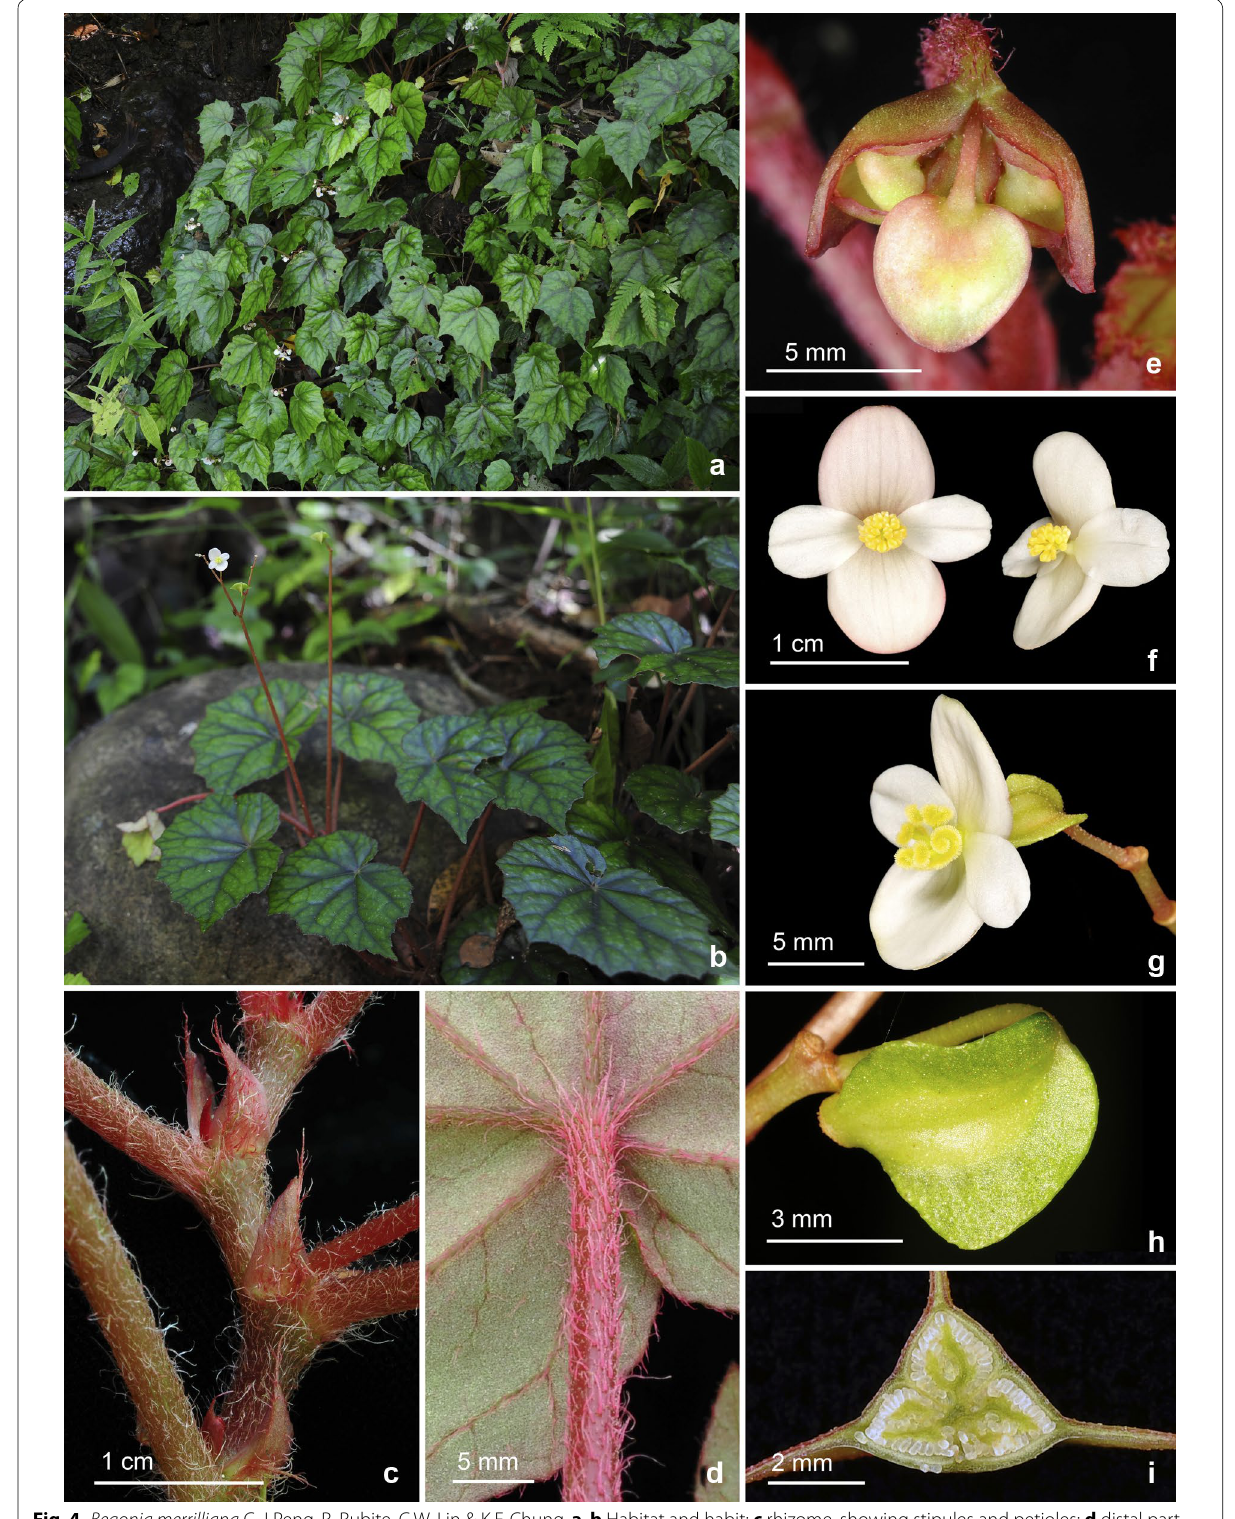
Fig. 4 Begonia merrilliana C.‑I Peng, R. Rubite, C.W. Lin & K.F. Chung. a , b Habitat and habit; c rhizome, showing stipules and petioles; d distal part of petiole, showing appressed villous vestiture; e immature inflorescence, showing bracts; f staminate flowers; g pistillate flower; h capsule; i cross section of an immature